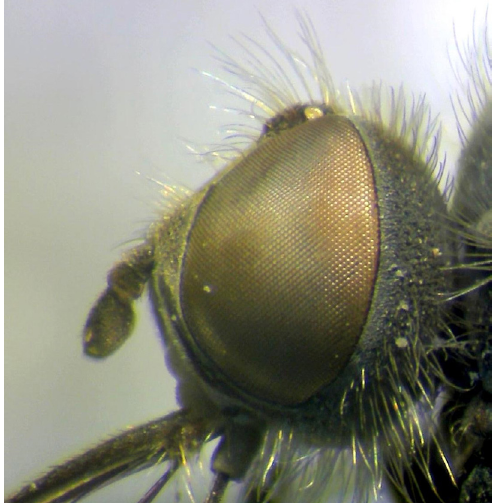
Fig. 32. Parusia almeria gen. et sp. nov.,